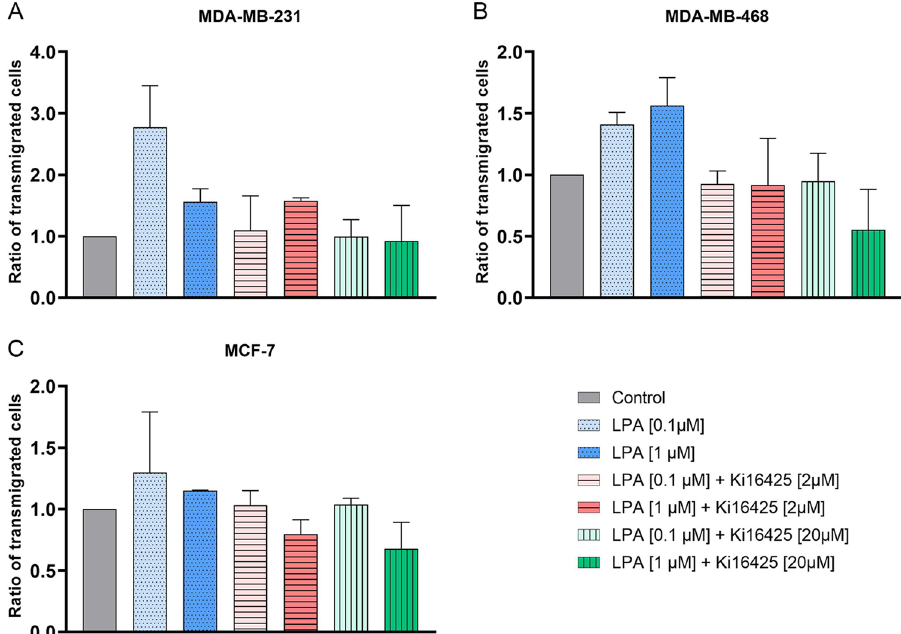
Figure 4. Transmigration assay. Effect of lysophosphatidic acid (LPA) 18:1 and the LPA receptor 1, 3 (and 2) inhibitor Ki16425 on transmigration of different human breast cancer cell lines (control = 1). (A–C) Columns show the ratio of transmigrated cells compared to the control group (y-axis) in varying concentrations of LPA and Ki16425 (x-axis). n = 2 replicate experiments. Values are presented as mean ± SD. For LPA 0.1 μM and